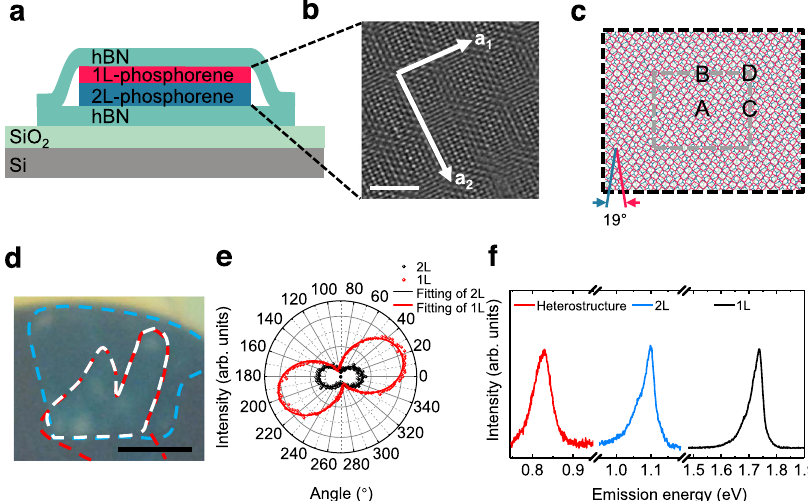
Fig. 1 Representative twisted monolayer/bilayer phosphorene heterostructures. a A side-view illustration of device ’ s con fi guration, where 1L and